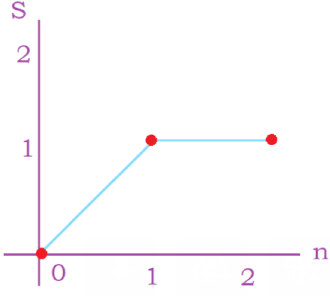
Figure 19 . The entropy S at T = 1 . 56 J , mimicking the bilayer curve in Figure 15. dynamic limit characteristic of infinite temperature and only when the fraction f exceeds 1 / 2 does the behavior deviate from the